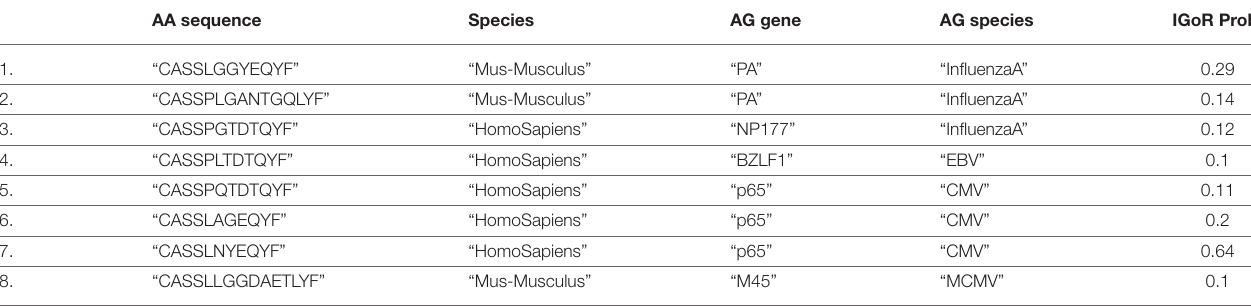
TABLE 1 | List of sequences from the VDJdb that matches CAs revealed via the machine learning process. AA